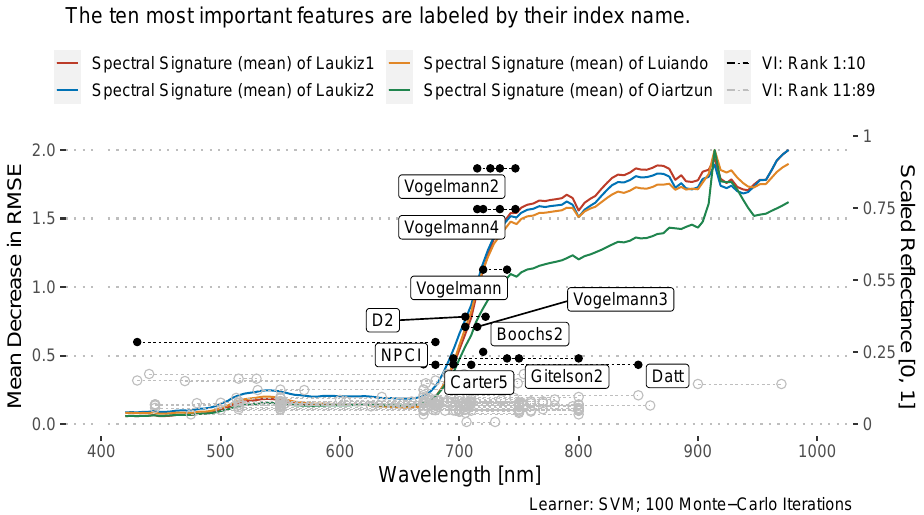
Figure 6. Variable importance for feature sets HR and VI: Mean decrease in RMSE for one hundred feature permutations using the SVM learner. The wavelength range on the x-axis matches the range of the hyperspectral sensor (400–1000 nm). For each dataset, the ten most important features are highlighted as black dots and labeled by name. Gray dots represent features from importance rank 11 to last. The spectral signature (mean) of each plot was added as a reference on a normalized reflectance scale [0, 1] (secondary y-axis). VI features were decomposed into their individual formula parts, all instances being connected via dashed lines. Each VI feature is composed out of at least two